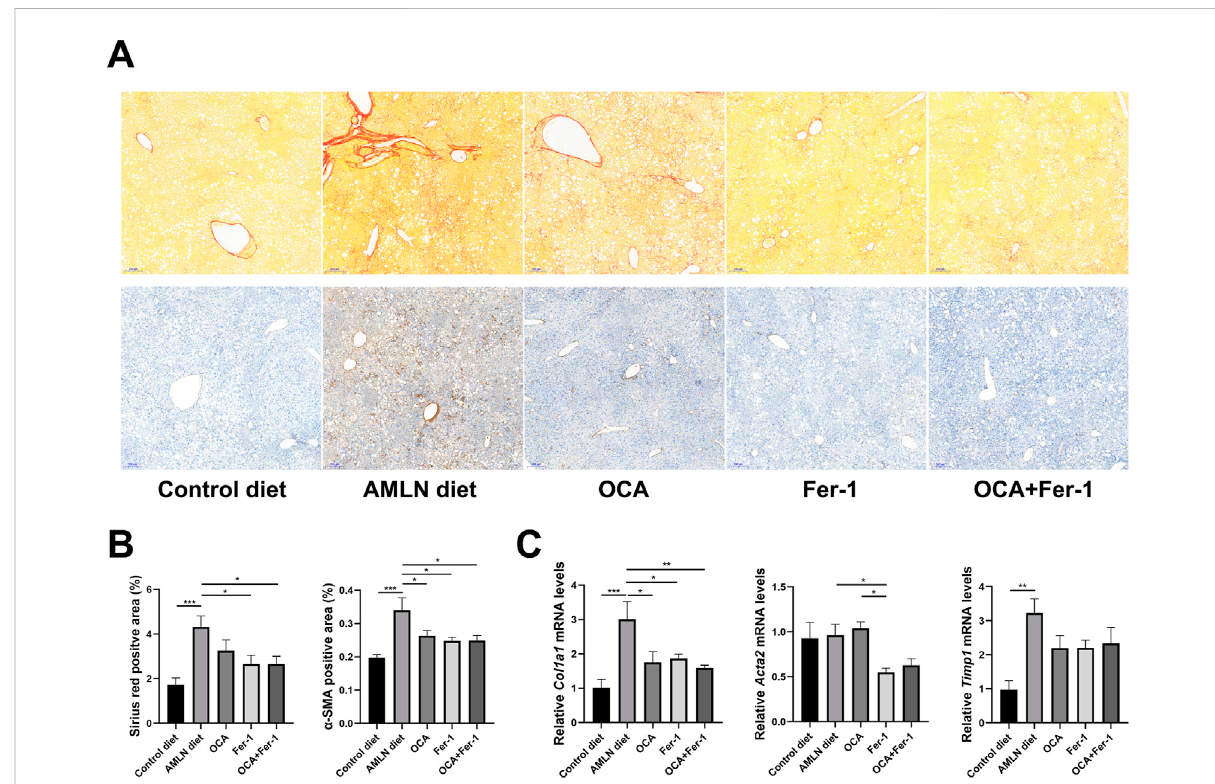
FIGURE 3 OCA and Fer-1 differentially inhibited activation of hepatic Kuppfer cell and HSCs (A) Representative sirius-red staining (upper) and α -SMA immunohistochemical (lower) staining of liver tissues (scale bar: 200 μ m). (B) The positive area of Sirius red staining and α -SMA staining. (C) Relative expression of fi brosis related genes ( Col1a1 , Acta2 and Timp1 ) in liver tissues. Data are shown as mean ± SEM. * p < 0.05, ** p < 0.01, *** p <